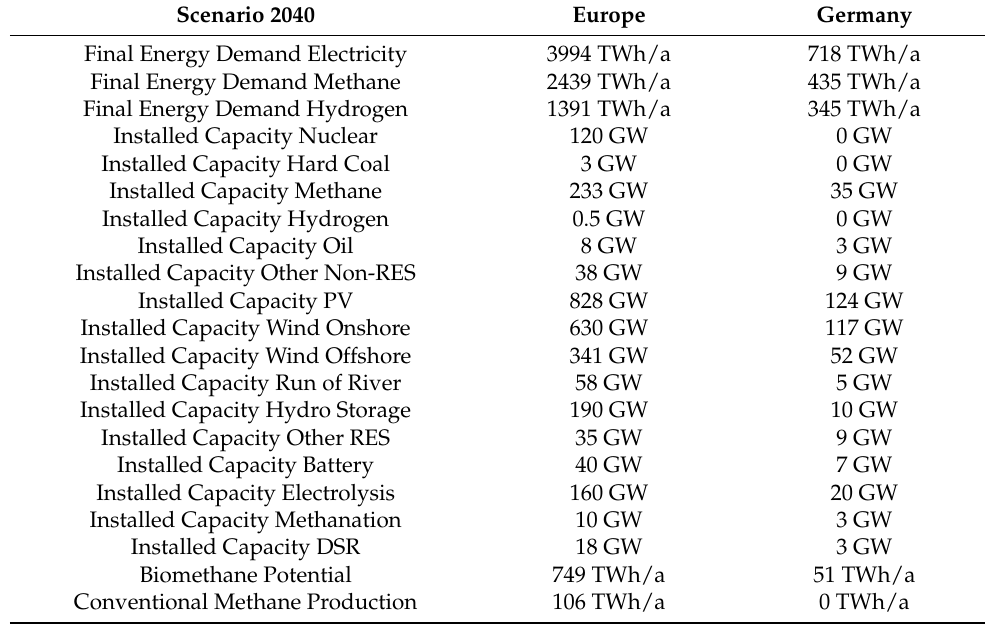
Table 5. Scenario data (modified based on [50]).